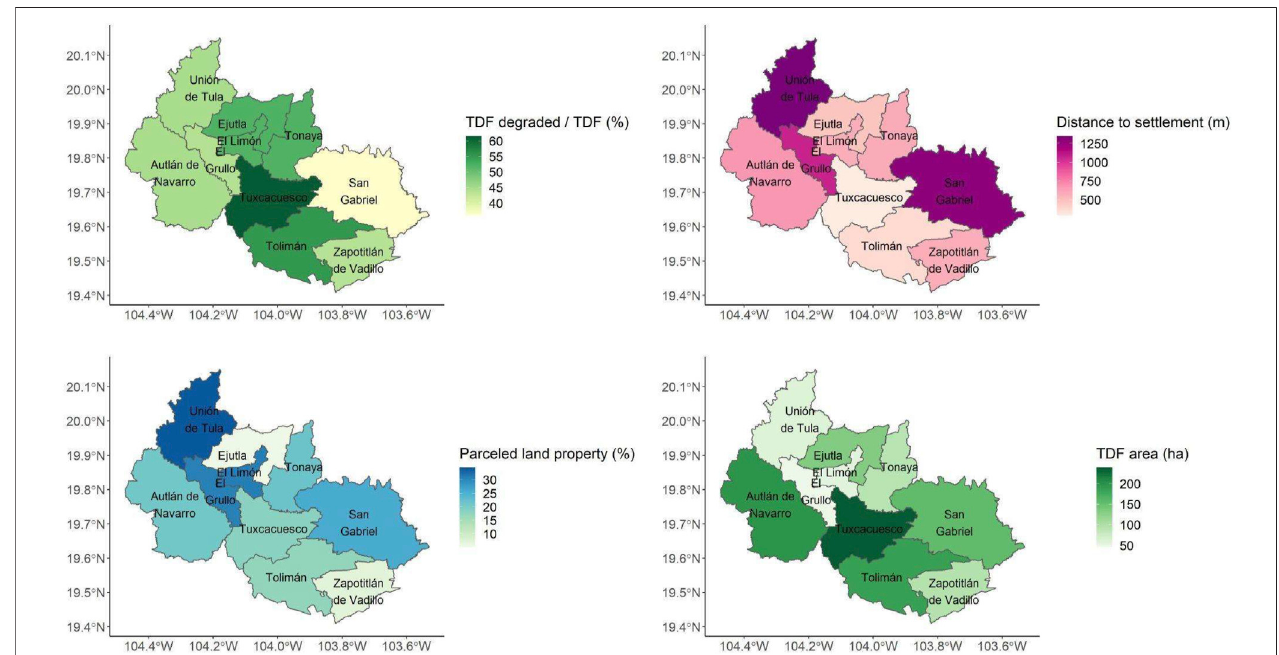
FIGURE 5 | The mapped degraded forest and the two biophysical and socio-economic factors relevant to explain the percentage of degraded forest by municipality.